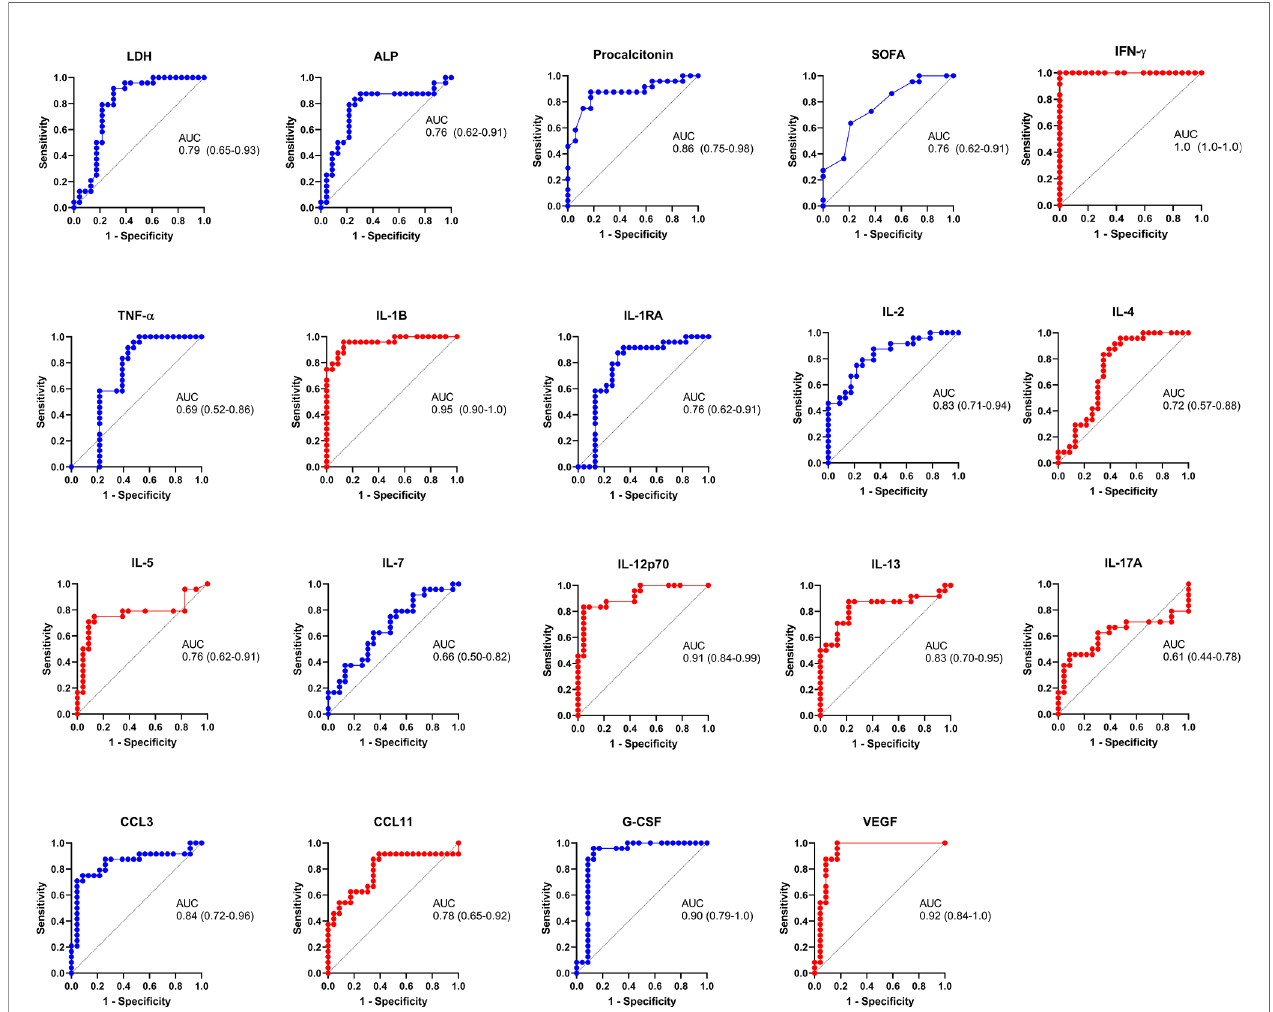
FIGURE 6 | Diagnostic value of the clinical and immunological factors that distinguish between severe COVID-19 and pandemic in fl uenza A(H1N1). Receiver operating characteristic (ROC) curves were constructed for the clinical and immunological characteristics that showed signi fi cant OR values in the bivariate logistic regression analysis. ROC curves of variables associated with pandemic in fl uenza A(H1N1) are shown in blue color, whereas variables associated with severe COVID- 19 are displayed in red color. The graphs show area under the curve (AUC) and 95% CI interval